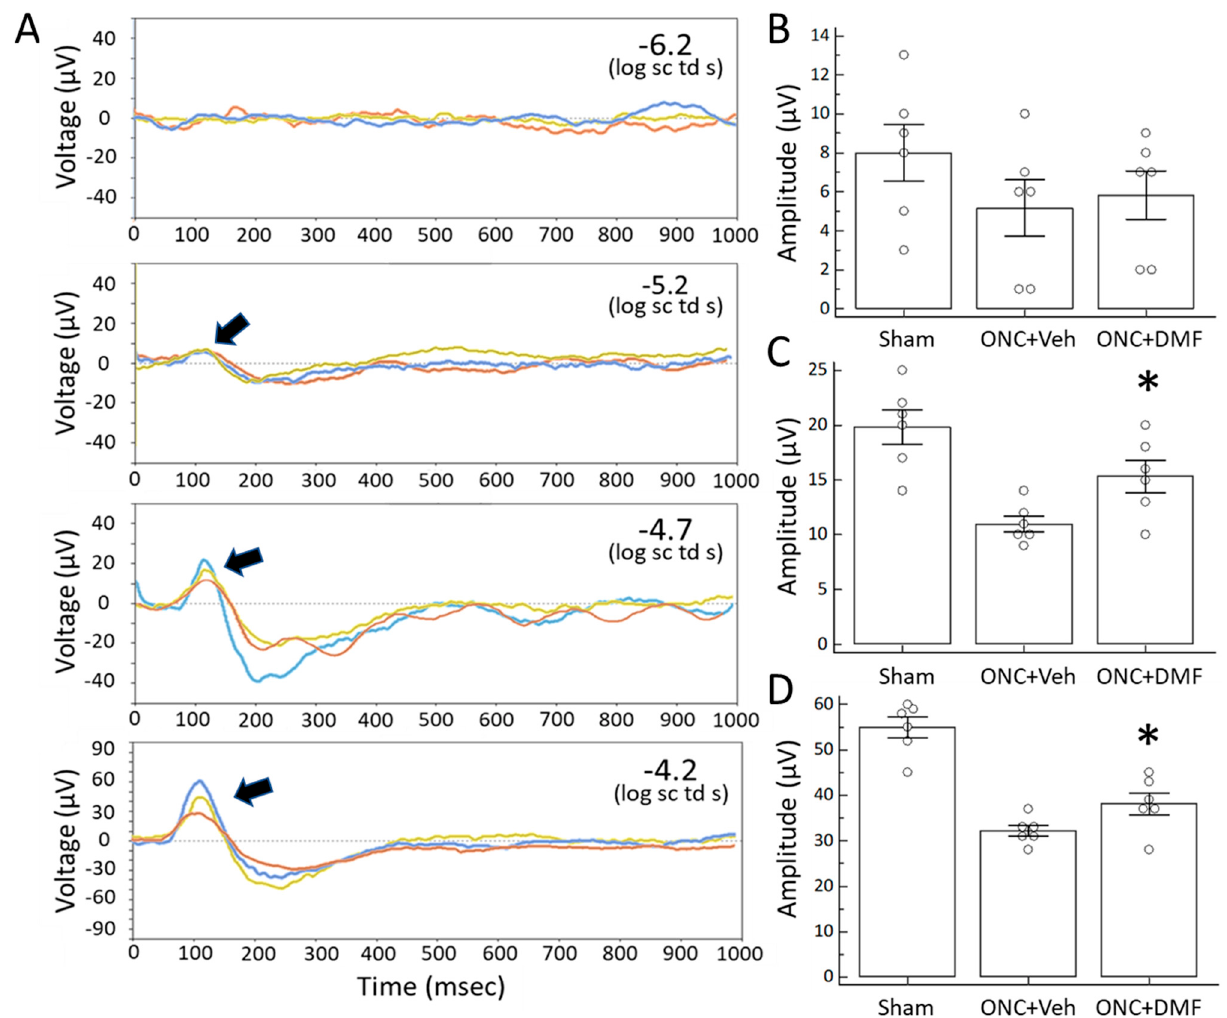
Figure 2. Scotopic threshold responses (STRs) elicited by a series of incremental dim-light stimuli. ( A ) Representative superimposed waves of STRs were recorded in mice (blue line, sham operation; red line, ONC with vehicle; yellow line, ONC with DMF at a concentration of 100 mg/kg). Arrows indicate the positive STR (pSTR). ( B – D ) Representation of the mean of the amplitudes of the pSTR in various dim-light stimuli. Each circle denotes the values of individual animals. ( B ) − 5.2, ( C ) − 4.7, and ( D ) − 4.2 log sc td s. Asterisks indicate p < 0.05 ( n = 6) compared to ONC with the vehicle (unpaired t -test).